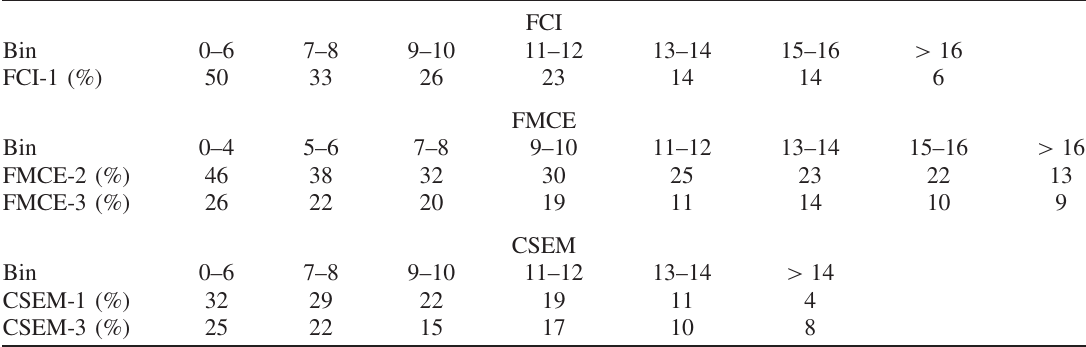
TABLE III. Percentage of women by uncorrected pretest